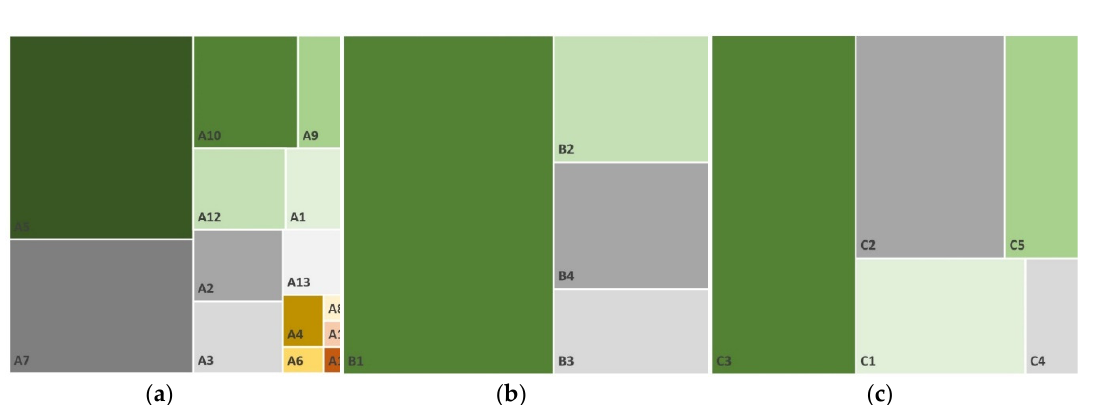
Figure 9. Classification and number of published papers according to ( a ) technique used; ( b ) computer tools; and ( c ) accuracy.